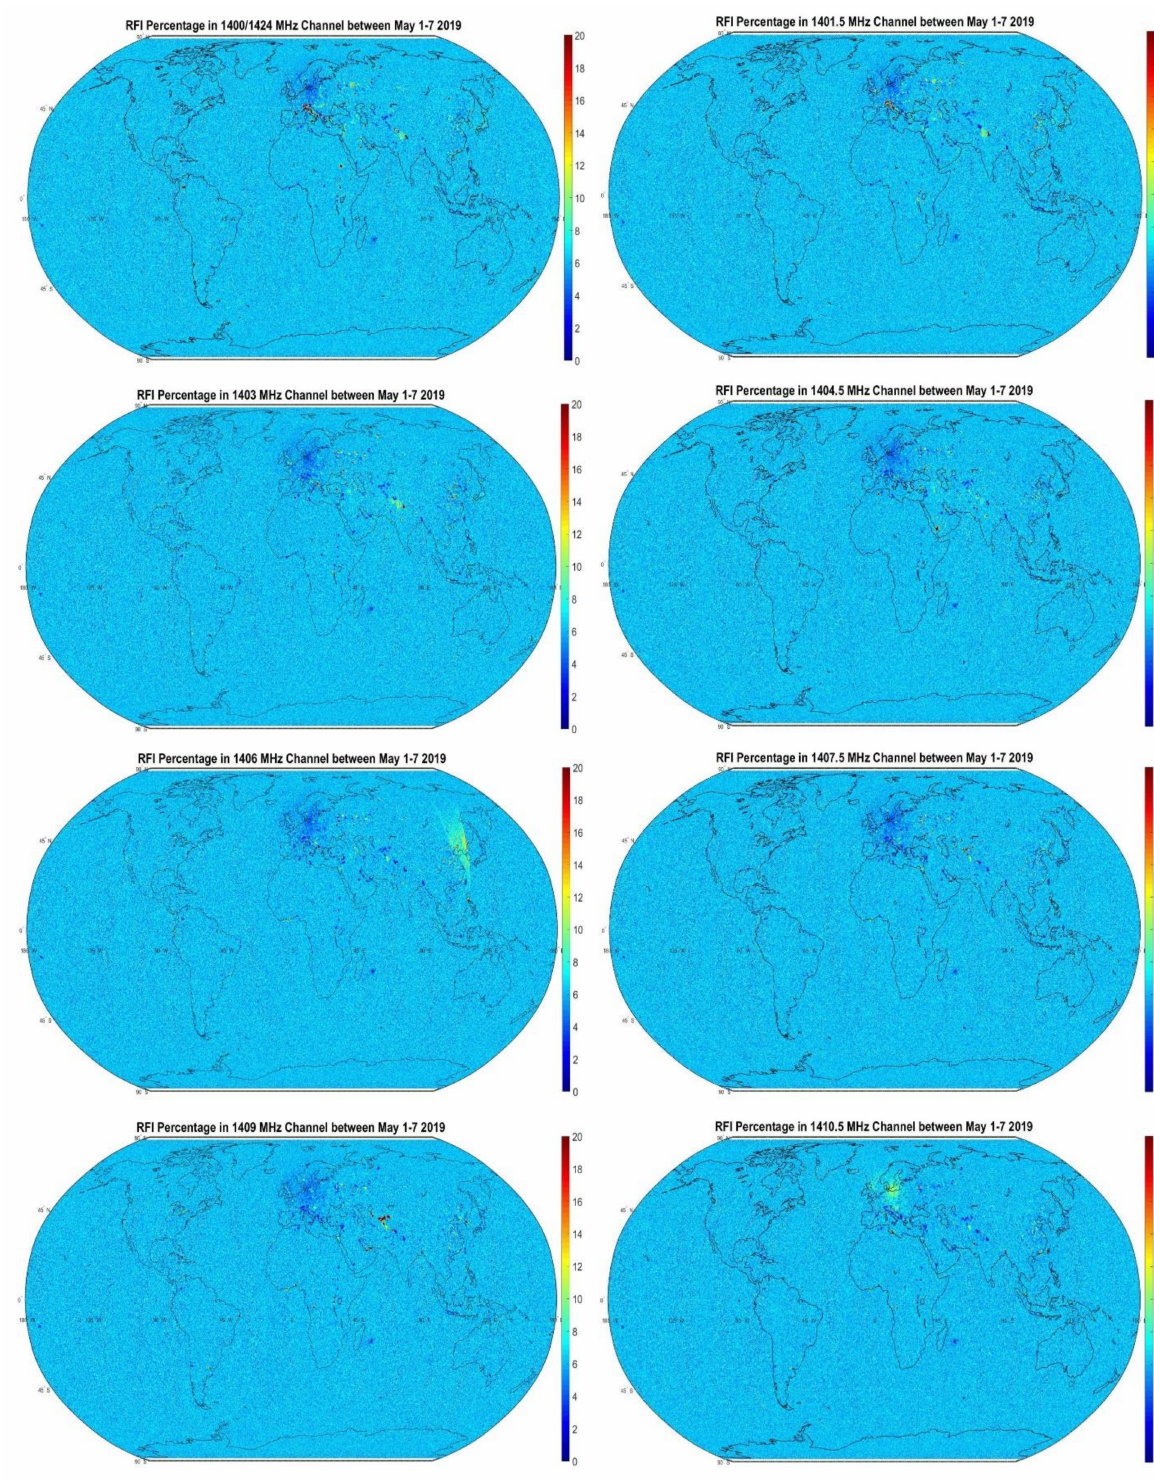
Figure 6. RFI percentage in 8 SMAP sub-band channels from 1400/1424 to 1410.5 MHz between 1 and 7 May 2019 on 0.25 ◦ × 0.25 ◦ gridded maps. The background non-zero RFI percentage is due to false alarms in RFI detection. Note the significant RFI presence over Italy at 1400/1424 and 1401.5 MHz, over Eastern Asia at 1406 MHz, over Central Asia at 1409 MHz, and over Northern Europe at 1410.5